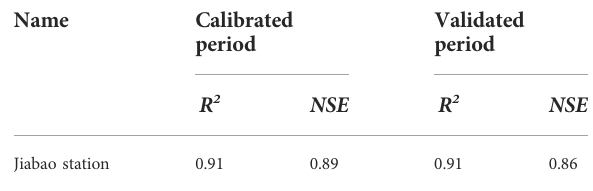
TABLE 3 Evaluation results of the simulation runoff.